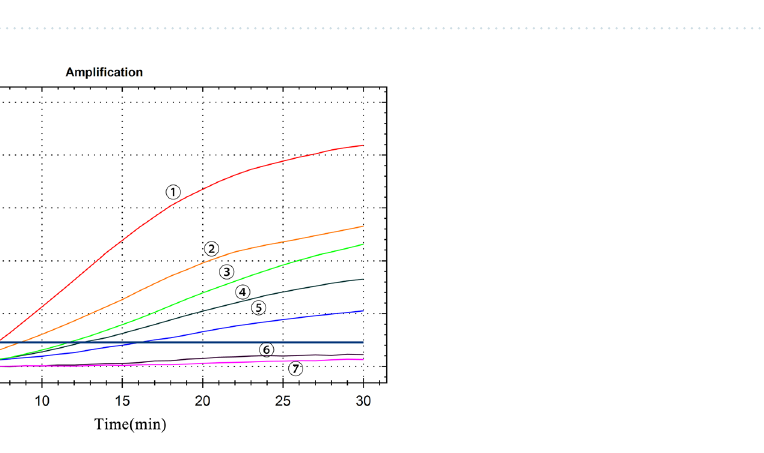
Figure 3. Specific test results: ① : GETV RNA, ② – ⑥ : JEV, CSFV, PRRSV, PEDV, TGEV RNA, ⑦ : negative control.